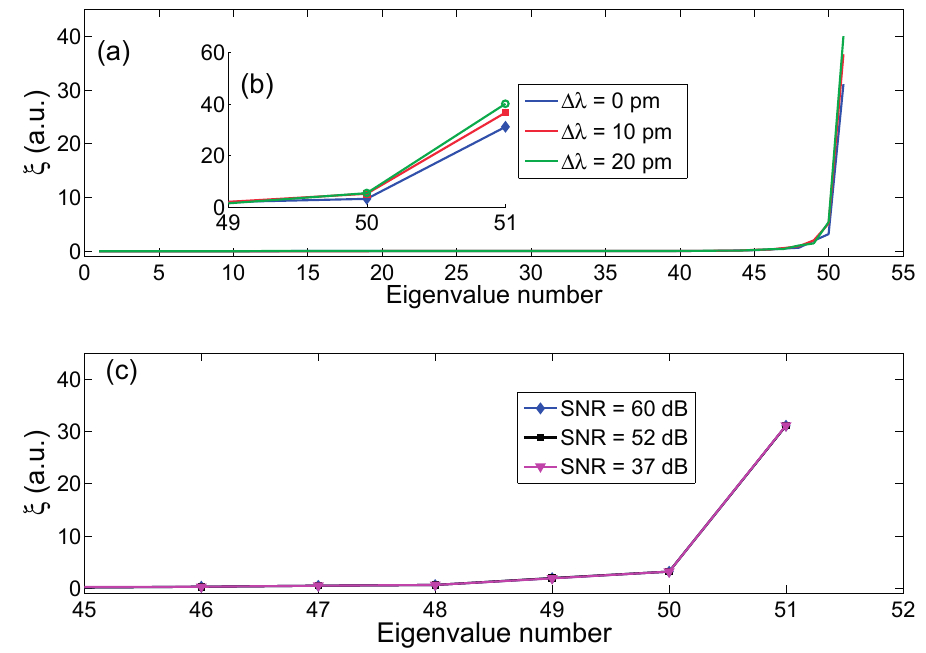
Figure 3. Outline of the KLT-SVD applied to the interrogation of an FBG. ( a ) The eigenvalue string ξ is reported for a grid of N = 51, for different values of wavelength shift Δλ = 0 pm, 10 pm, and 20 pm, all having SNR = 60 dB; ( b ) The inset shows the three high-rank eigenvalues from ( a ), highlighting in particular the highest eigenvalue ξ N ; ( c ) For Δλ = 0 pm, the eigenvalue string ξ is reported for different values of SNR: 60 dB, as in ( a ), 52 dB, and 37 dB.